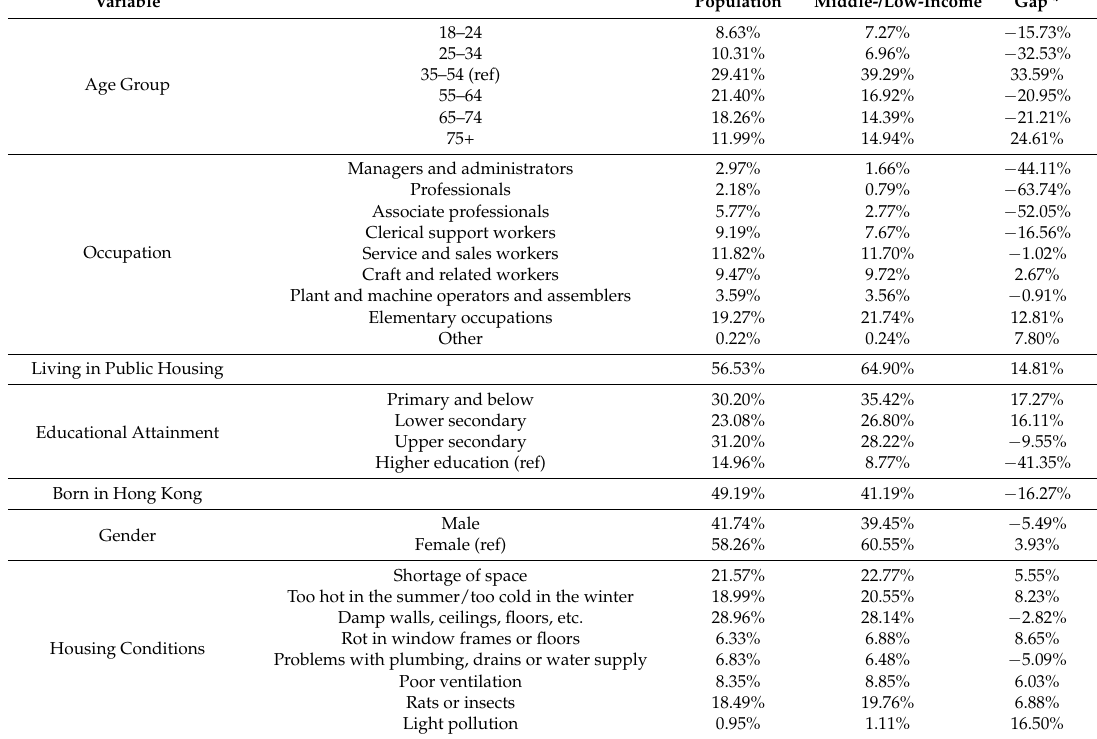
Table 2. Controlled variables and community/housing